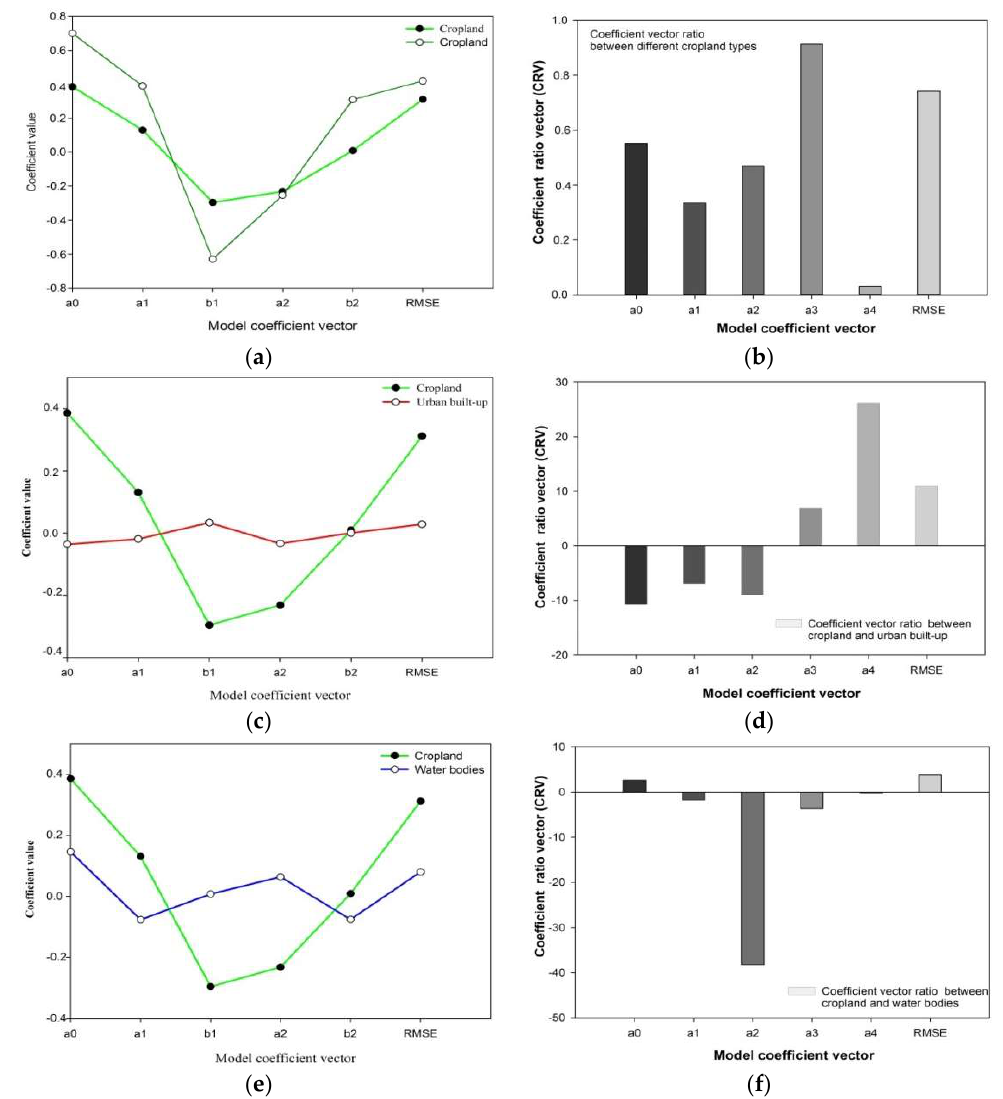
Figure 7. The signs and value differences of the coefficient ratio vector ( CRV ) between different land cover types. ( a ) model coefficient difference caused by different cropland type; ( b ) CRV between different cropland type; ( c ) model coefficient difference caused by change from cropland to urban built-up; ( d ) CRV between cropland and urban built-up; ( e ) model coefficient difference caused by change from cropland to water bodies; ( f ) CRV between cropland and water bodies.